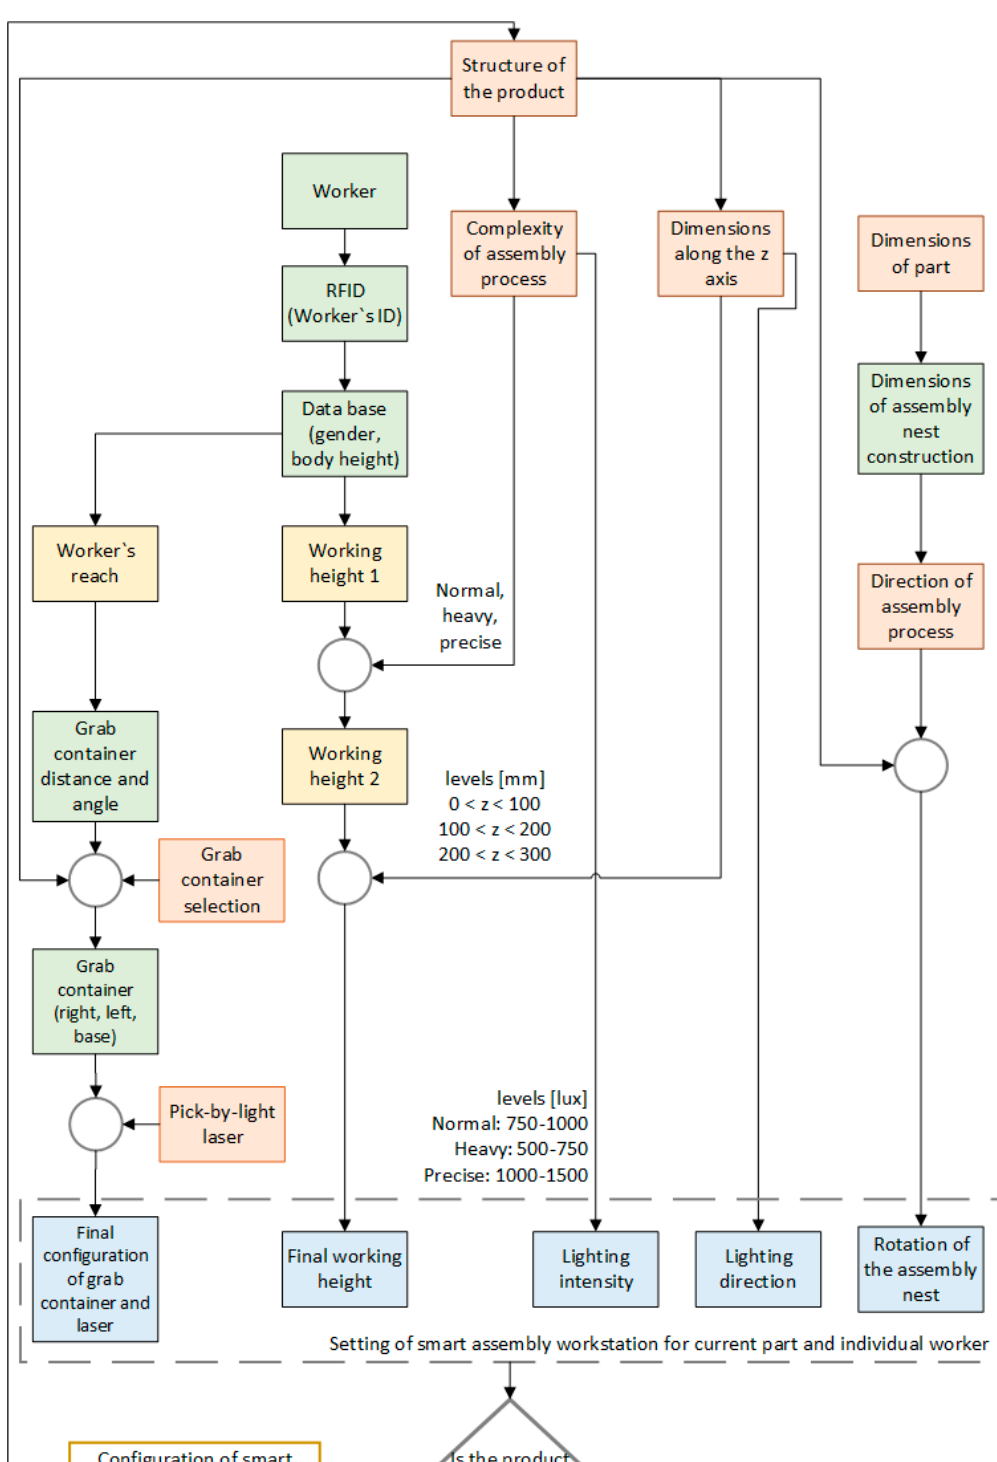
Figure 4. Block diagram of the smart algorithm.